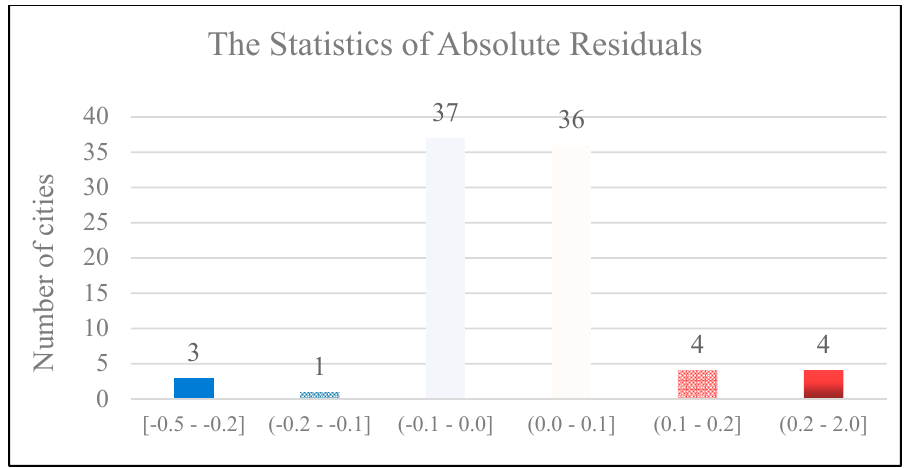
Figure 11. The statistical result of the absolute residuals by using OSM road network density and population.